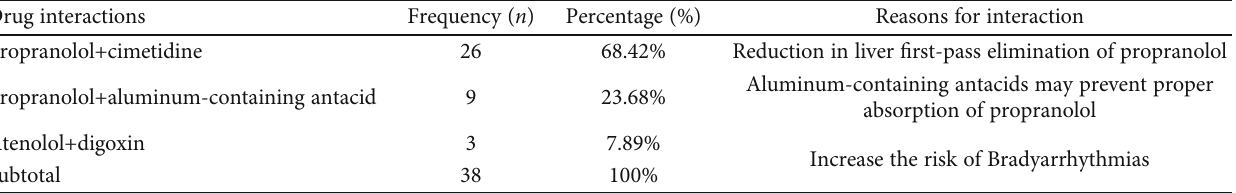
Table 5: Potential drug interaction between some concomitantly prescribed drugs with beta-blockers in the medical wards of NGH within 2